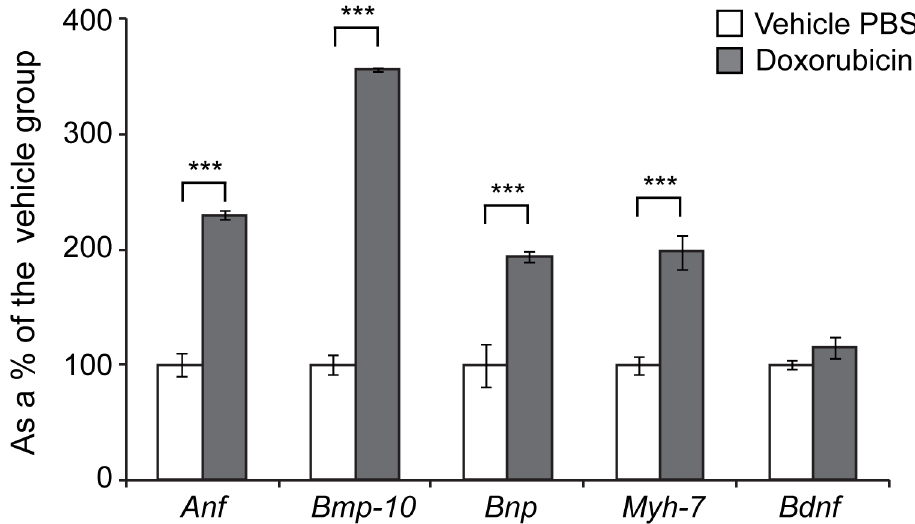
Fig 3. Re-activation of foetal gene markersin hearts treated with doxorubicin. Anp (atrial natriuretic peptide), Bmp-10 (brain morphogentic protein 10), Bnp (brain natriuretic protein), and Myh-7 (myosin heavy chain beta) were elevatedin the hearts treated with doxorubicin. Bdnf (brain derived neurotophicfactor) mRNA remainedunchanged. All Taqman qPCR values were normalized to the geometric mean of three housekeeping genes: Actb , Cyc1 and Gapdh . Error bars are SEM (n = 6). One-way ANOVA with Bonferroni post-hoc test: * p < 0.05, ** p < 0.01; *** p < 0.001.